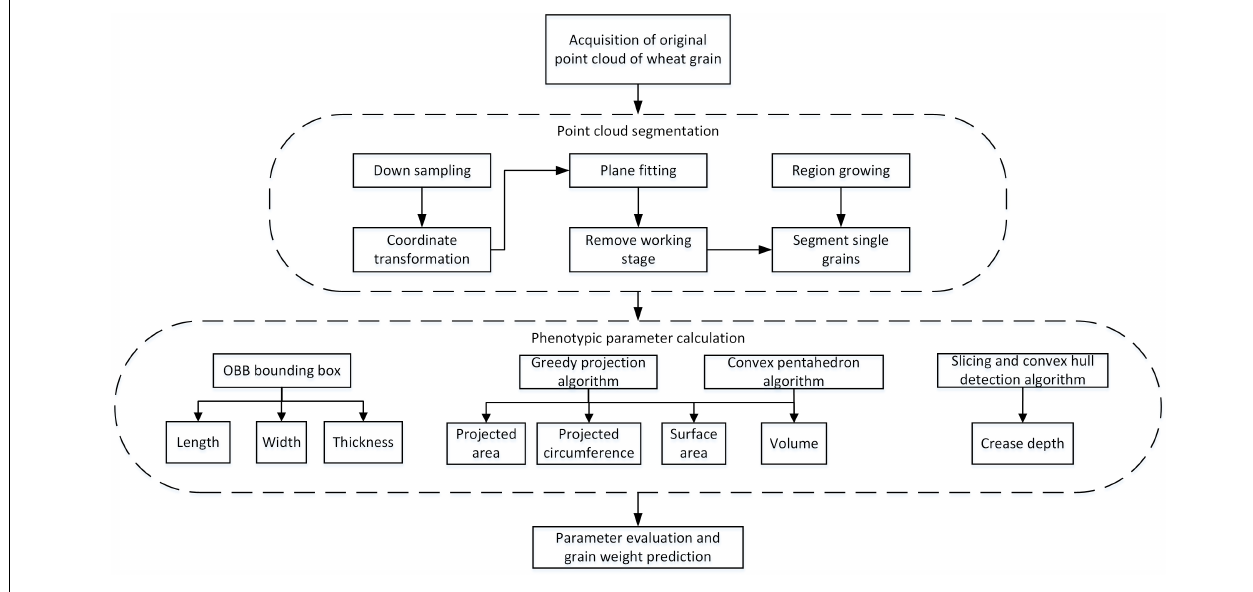
FIGURE 4 | Wheat grain analysis pipeline.